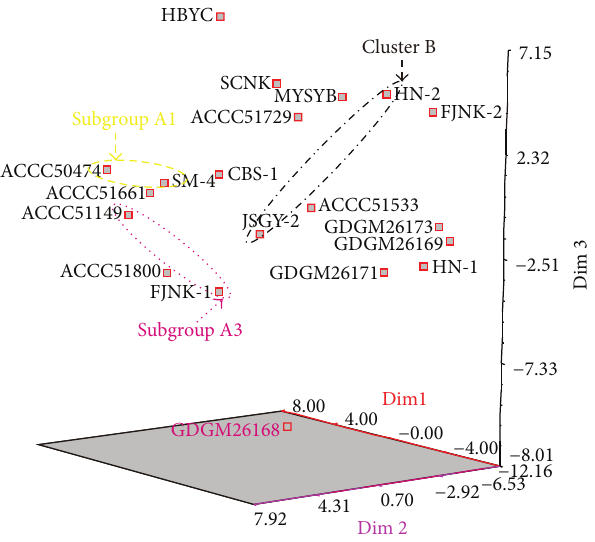
Figure 3: Three-dimensional map of principal coordinates analysis based TRAP data (black ellipse, cluster B; yellow ellipse, subgroup A1; pink ellipse, subgroup